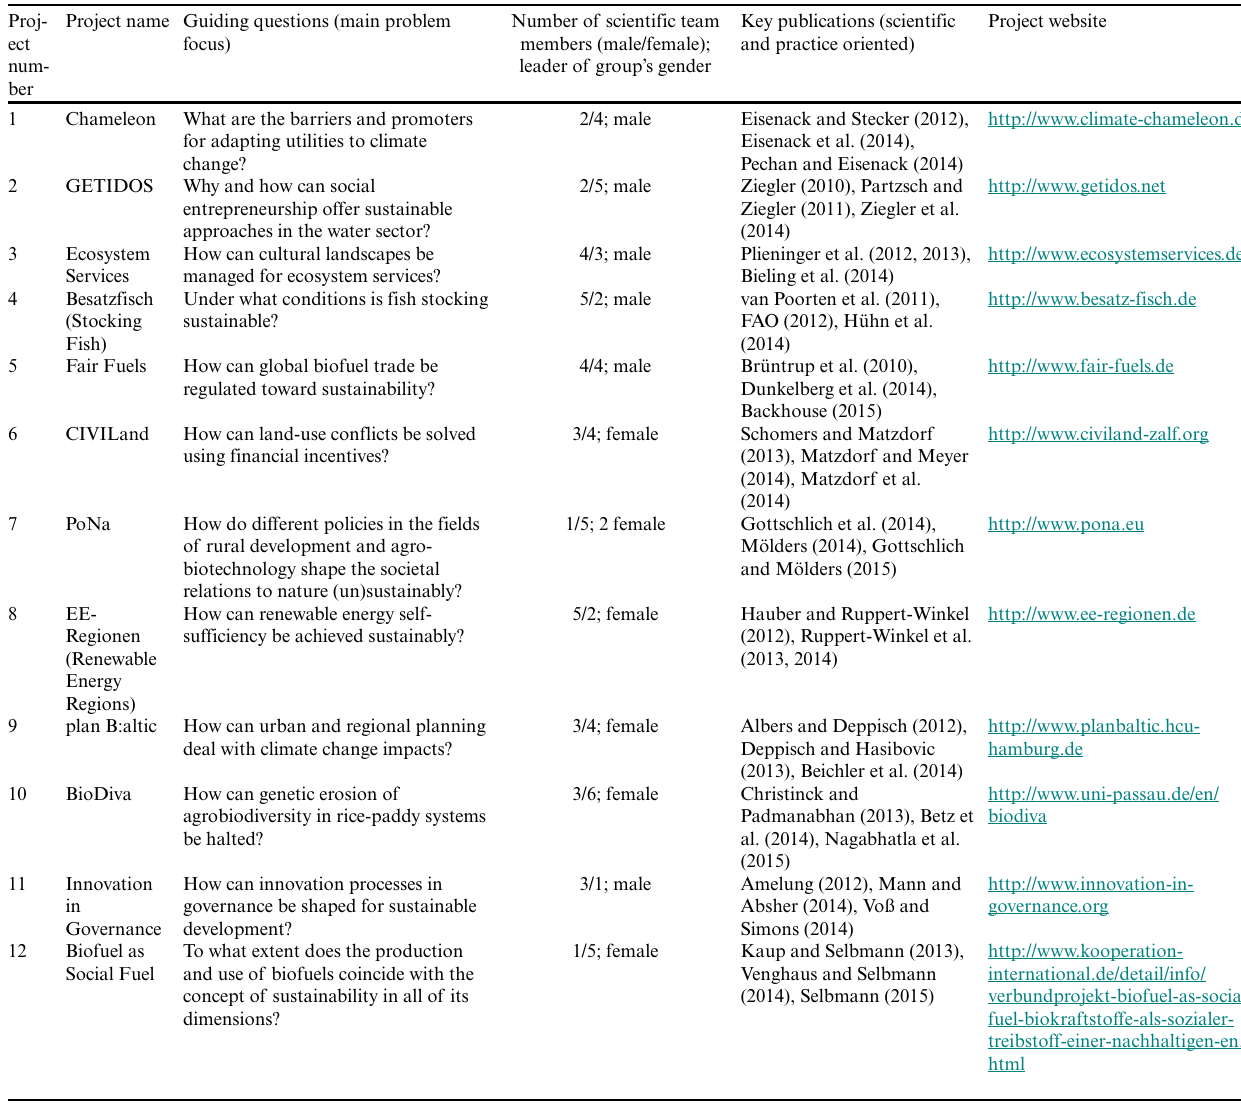
Table 1. Overview of the 12 social-ecological research groups funded within the Program for Social-Ecological Research in Germany, 2008–2014. Proj­ ect num­